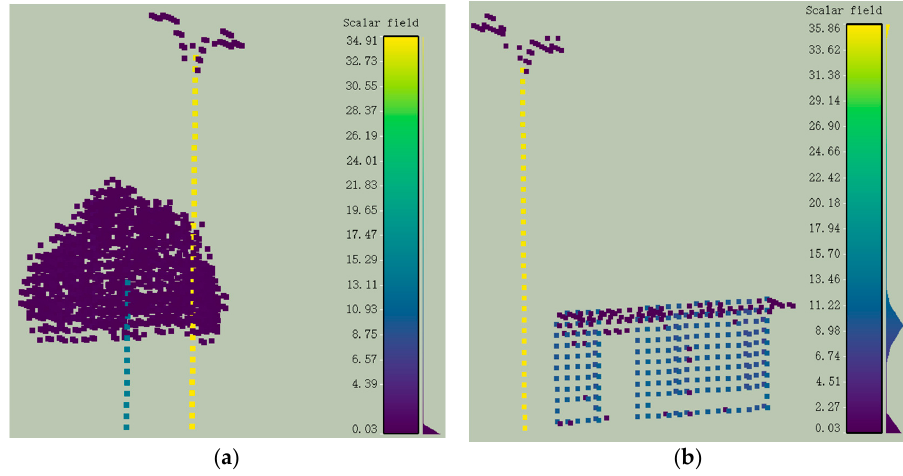
Figure 3. Examples of two scenes using the proposed density measurement.